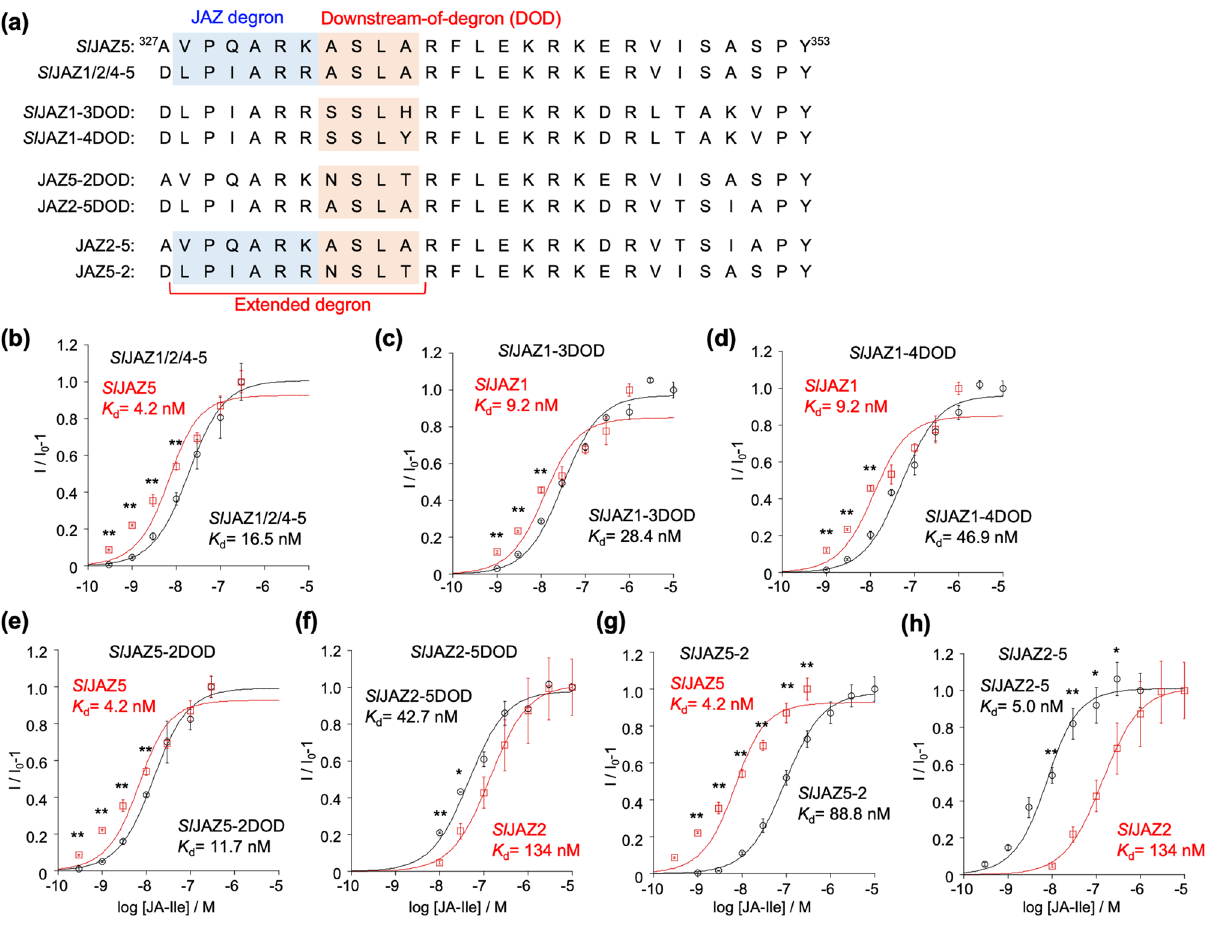
Figure 4. ( a ) Design of the swapped Sl JAZ peptides ( Sl JAZ5, 1/2/4-5, 1-3DOD, 1-4DOD 5-2DOD, 2-5DOD, 2-5, 5-2). Canonical JAZ degron sequences are shown in blue and down-stream-of-degron (DOD) sequence are in orange. ( b ) AlphaScreen assay using GST- Sl COI1 and Fl- Sl JAZP1/2/4-5 (black circle) or Fl- Sl JAZ5 (red square) with JA-Ile (0–300 nM). ( c – h ) Alphascreen assays of swapped Fl- Sl JAZPs ( c : SlJAZ1-3DOD, d :